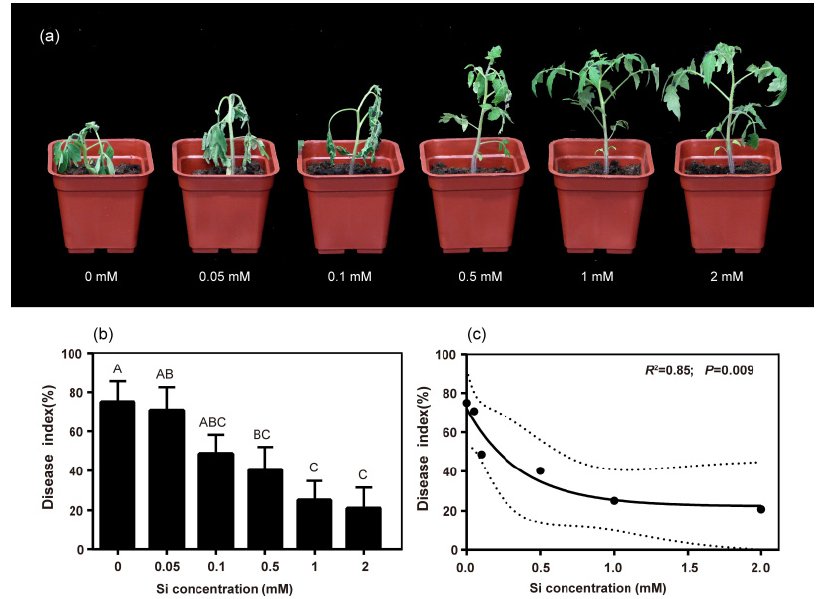
Figure 1. Effects of Si concentration on the disease index of bacterial wilt in tomato. ( a ) Effects of different Si concentrations on tomato plants under R. solanacearum inoculation conditions. ( b ) Disease index at 20 days post inoculation (dpi). ( c ) The simple linear regression (solid line) and 95% confidence interval of the regression (dashed line) for the disease index at 20 dpi and Si concentration in peat soil. Different letters among treatments denote statistical difference at p < 0.05 according to Duncan’s new multiple range tests.